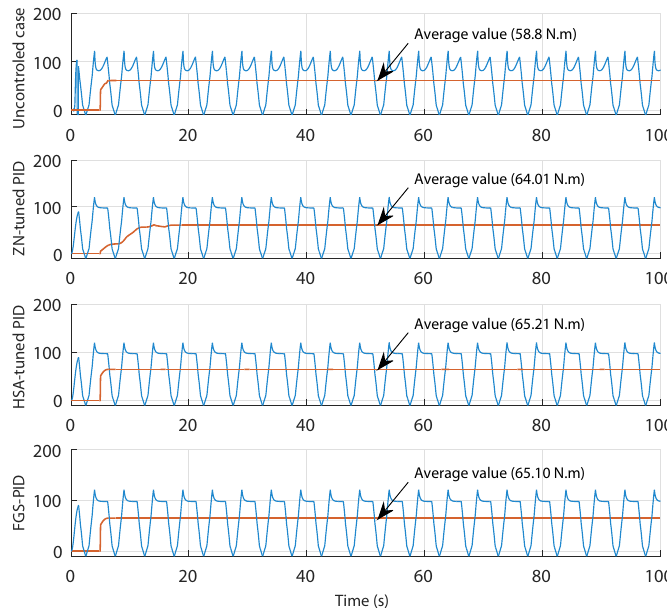
Figure 19. Turbine torque with different control methodologies in regular